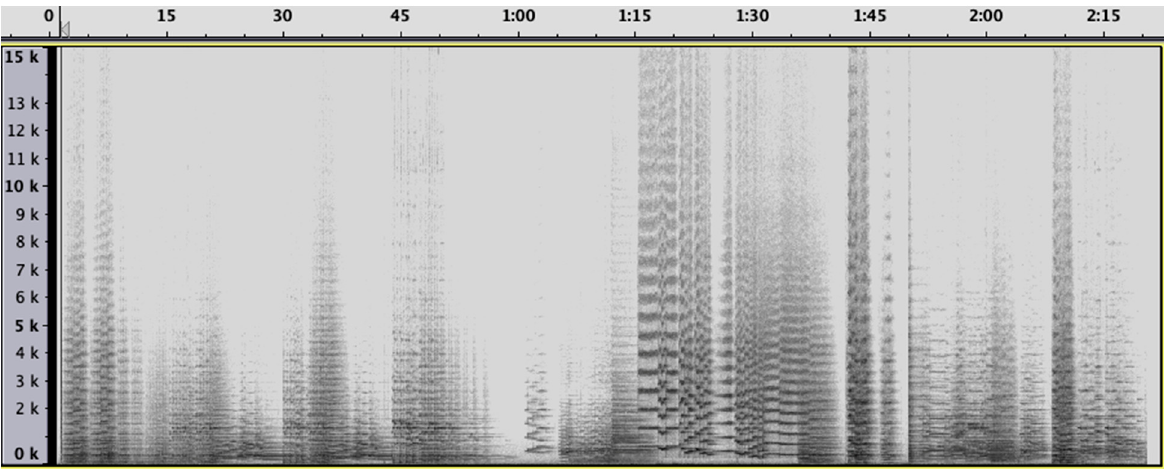
Figure 1. Spectrogram of the first 2 minutes of Sibelius’ second symphony, first movement. The picture reads as a succession of distinct acoustic biotopes.